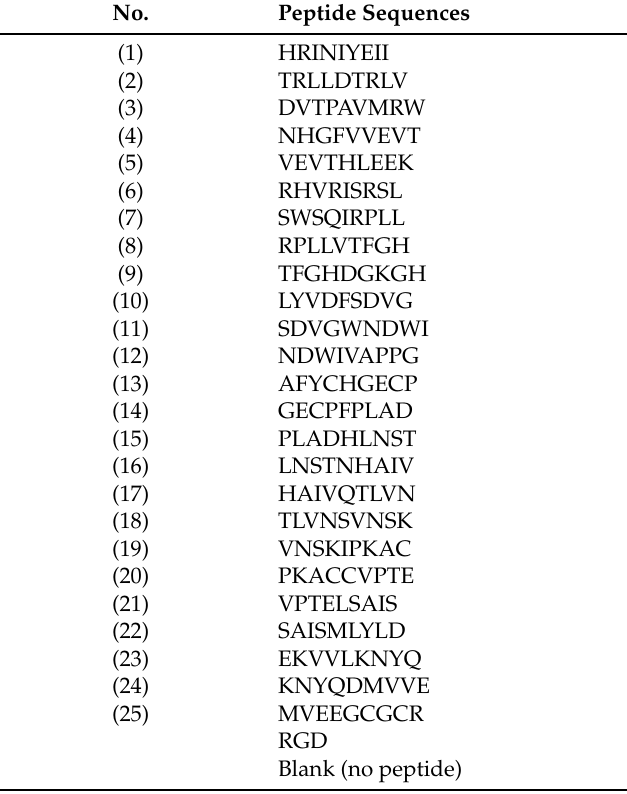
Table 2. Candidate peptides for the peptide array